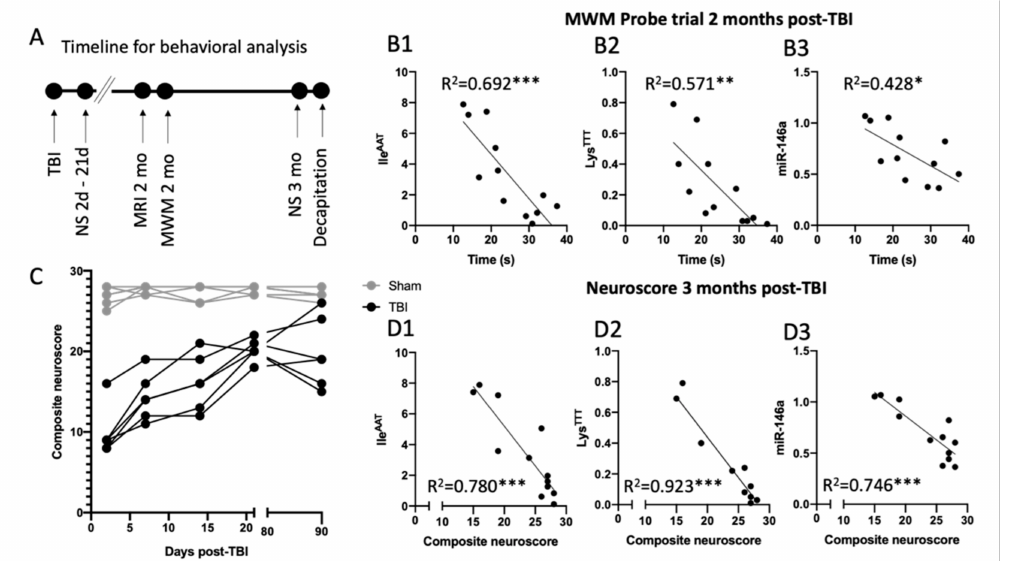
Figure 10. Upregulation of tRFs in the ipsilateral thalamus correlated with a worse behavioral outcome after traumatic brain injury (TBI). ( A ) Neuromotor function was assessed by the composite neuroscore at acute and chronic time-points post-TBI, and memory deficits were investigated with the Morris water maze at 2 months post-TBI. ( B1–B3 ) Correlation analysis showed that rats showing deficits in the probe trial, represented by less time spent in the correct quadrant, also had the highest expression of the full miR-146a profile (all isomiRs included; Spearman r = 0.43, p < 0.05, panel ( B1 )), 3 (cid:48) tRF-IleAAT (Spearman r = 0.70, p < 0.001; panel ( B2 )), and 3 (cid:48) tRF-LysTTT (Spearman r = 0.57, p < 0.01; panel ( B3 )). ( C ) TBI rats exhibited acute motor function deficits compared with controls at 2 days post-TBI ( p < 0.01) with recovery to subacute at 7 days ( p < 0.01, compared with controls), 14 days ( p < 0.01, compared with controls) and 21 days ( p < 0.01, compared with controls) post-TBI time-points. At 3 months post-TBI, high variance in the measured score was observed between rats, but lower scores were still observed compared with controls ( p < 0.01). ( D1 – D3 ) Correlation analysis indicated a relation between a lower neuroscore value at 3 months post-TBI and increased expression of the full miR-146a profile (all isomiRs included; Spearman r = 0.75, p < 0.001; panel ( D1 )), 3 (cid:48) tRF-IleAAT (Spearman r = 0.78, p < 0.001, panel ( D2 )) and 3 (cid:48) tRF-LysTTT (Spearman r = 0.92, p < 0.001; panel ( D3 )). Statistical significance: *, p < 0.05; **, p < 0.01; ***, p <